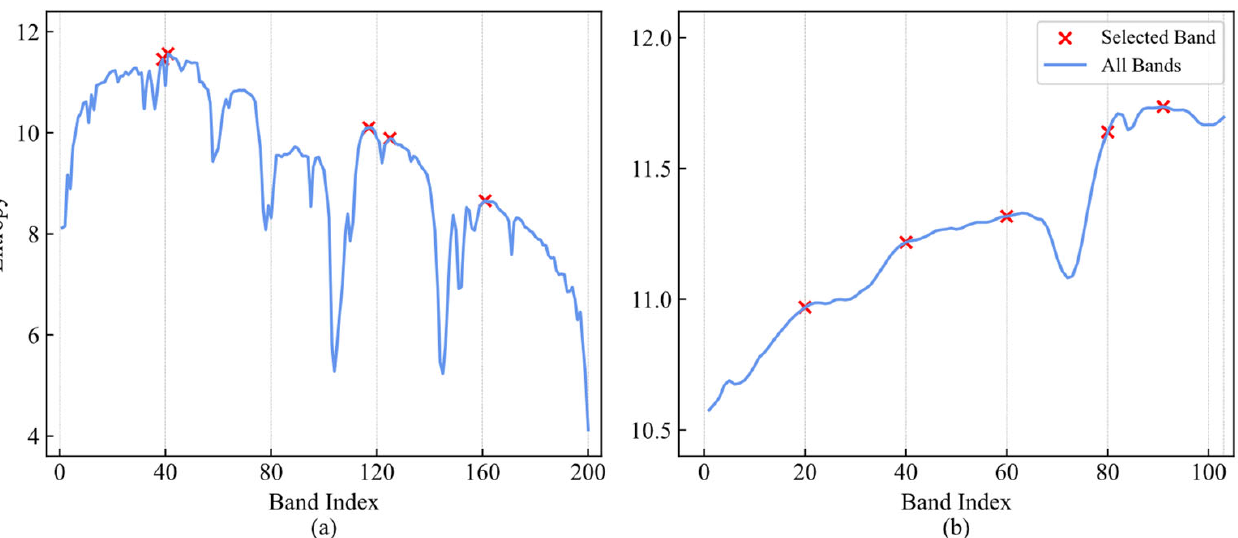
Algorithm 1: Procedure of SSGIE ‐ KFCM